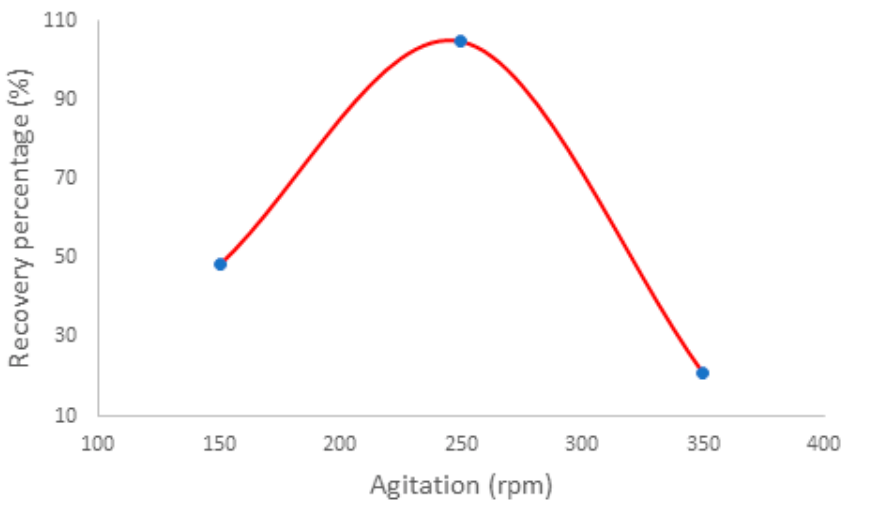
Figure 3. Recovery percentage of MG, related to the color intensity of channel R, as a function of agitation speed. Using 2.0 mg of polyimide nanofiber in contact with 50.0 mL of MG solution at 0.1 mg/L.